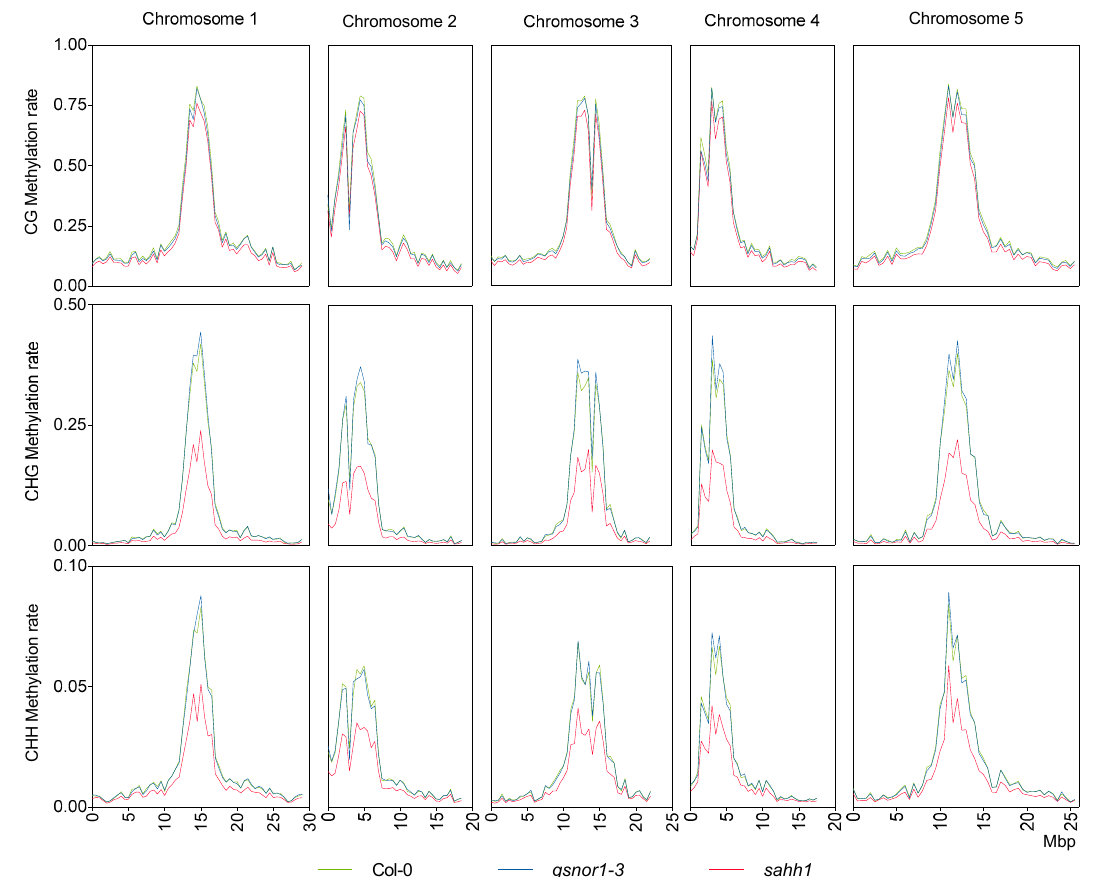
Figure 4. Chromosomal distribution of DNA methylation is altered in gsnor1-3 and sahh1. The methylation levels across the chromosomes in each sequence context were calculated with MethGeno [86] for each replicate. Then, replicates were merged, and graphs were made with GraphPad Prism. Average methylation of all cytosines within a 0.5 Mbp interval is plotted.